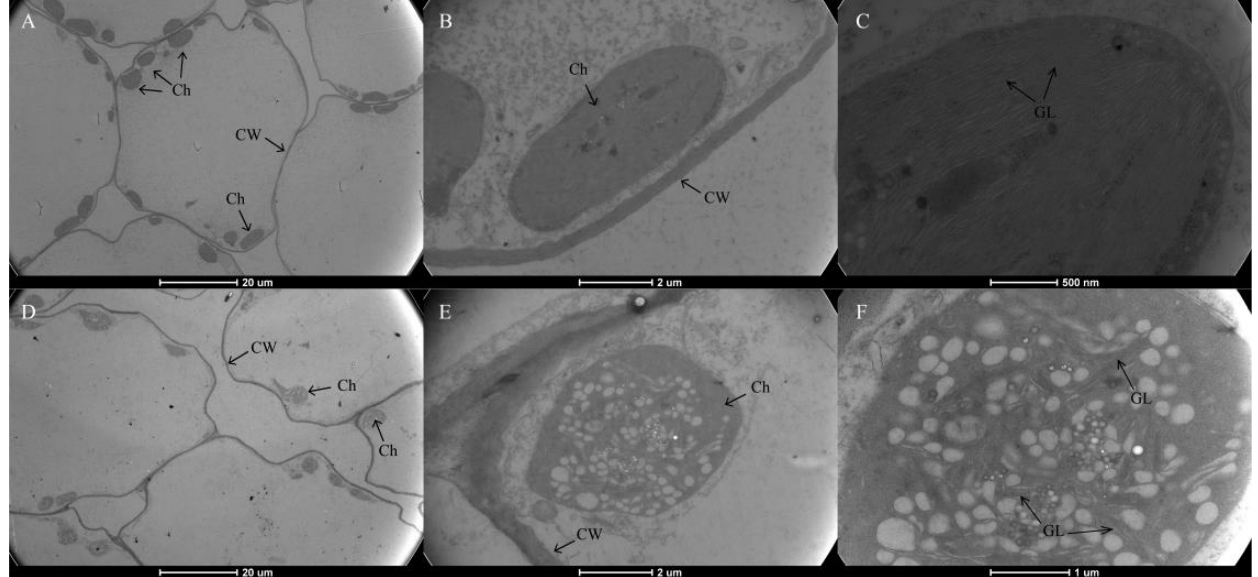
Figure 2. Transmission electron micrograph of chloroplasts from P. SCBG COP15 and the yellow mutant. ( A – C ) Chloroplast ultrastructures in the green leaves were intact, clearly visible, and well-organized. ( D – F ) The ultrastructure of mutant chloroplasts had serious defects, were packed with vesicles, and are filled with many plastid spheres. Ch: chloroplast; CW: Cell Wall; GL: grana lamella.